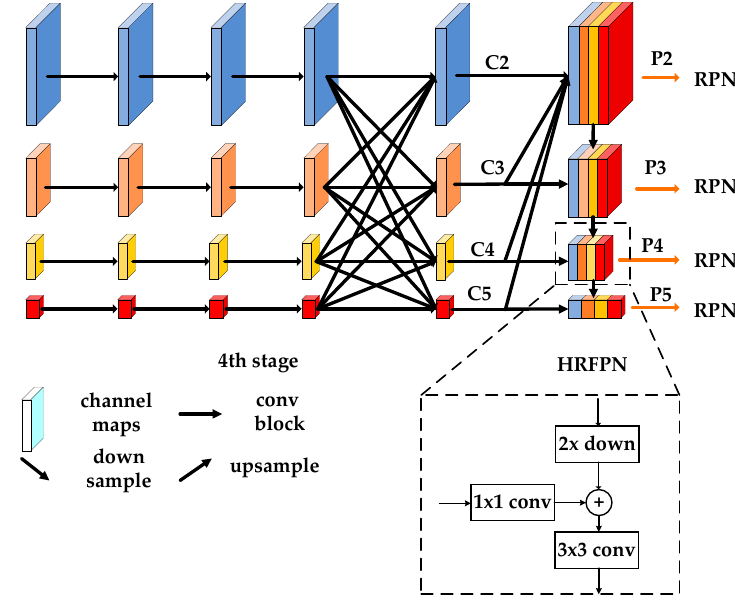
Figure 6. The architecture of the HRFPN block.